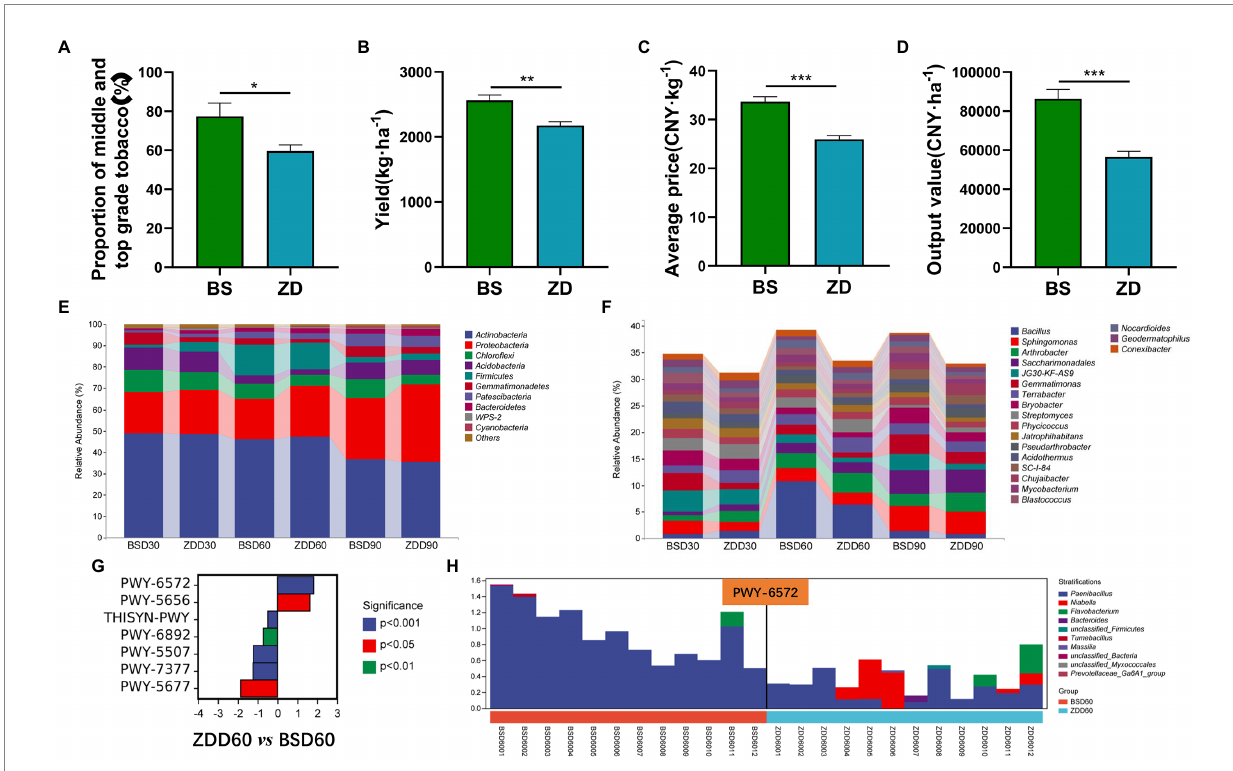
FIGURE 5 Differences in the flue-cured tobacco production characteristics and rhizosphere microbiota diversity in different regions. (A) . Proportion of middle- and top-grade flue-cured tobacco in different regions. (B) . Production of flue-cured tobacco in different regions. (C) . Average price of flue-cured tobacco in different regions. (D) . Output price of flue-cured tobacco in different regions. (E) . Composition and distribution of rhizosphere microbiota of flue-cured tobacco at the phylum level in different regions and stages. (F) . Composition and distribution of rhizosphere microbiota of flue-cured tobacco at the genus level in different regions and stages. (G) . Difference analysis of metabolic pathways involved in the rhizosphere microbiota of flue-cured tobacco in different regions at the Day 60 transplantation stage. (H) . Species composition and distribution of metabolic pathways (PWY- 6572) involved in the rhizosphere microbiota of flue-cured tobacco in different regions at the Day 60 transplantation